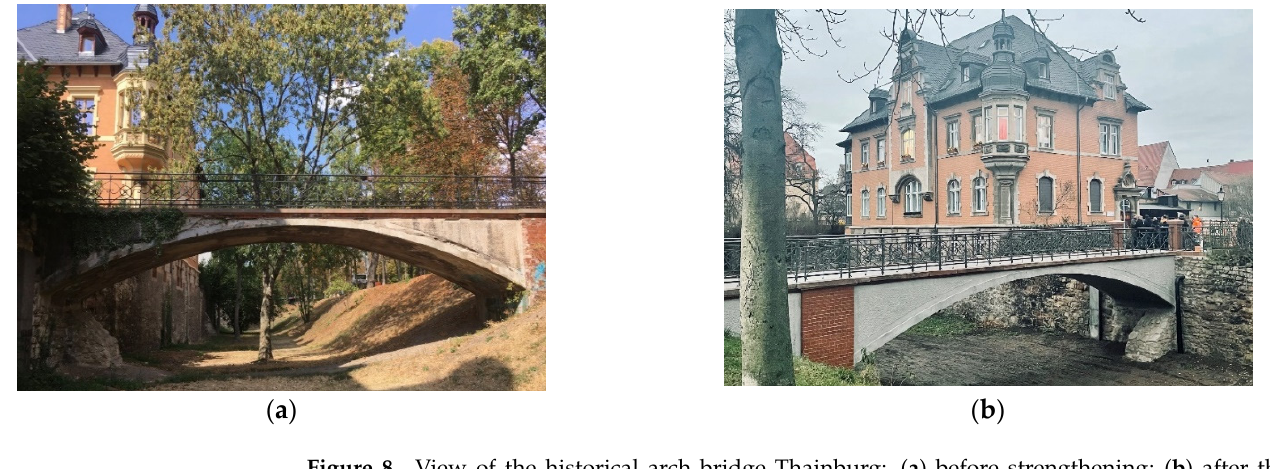
Figure 9. View of the motorway bridge over the river Nidda. (Photo: Oliver Steinbock).